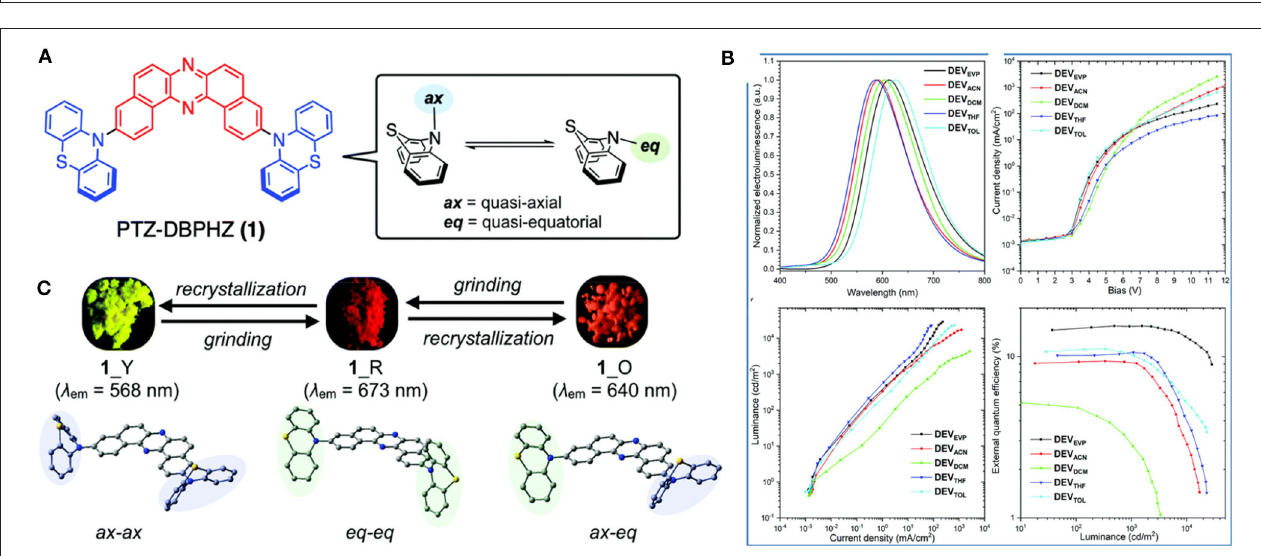
FIGURE 13 | (A) Structures of AzQx, IDBQz, ISBQx, OIDBQx. (B) DF intensity vs. laser pulse energy plot of OIDBQx (at 295K); (C) PL decay transients of OIDBQx at different temperature; (D) DF and RTP spectra (at 295K) with different excitation pulse energy. Reproduced with permission from Pashazadeh et al. (2018a). Copyright © The Royal Society of Chemistry.